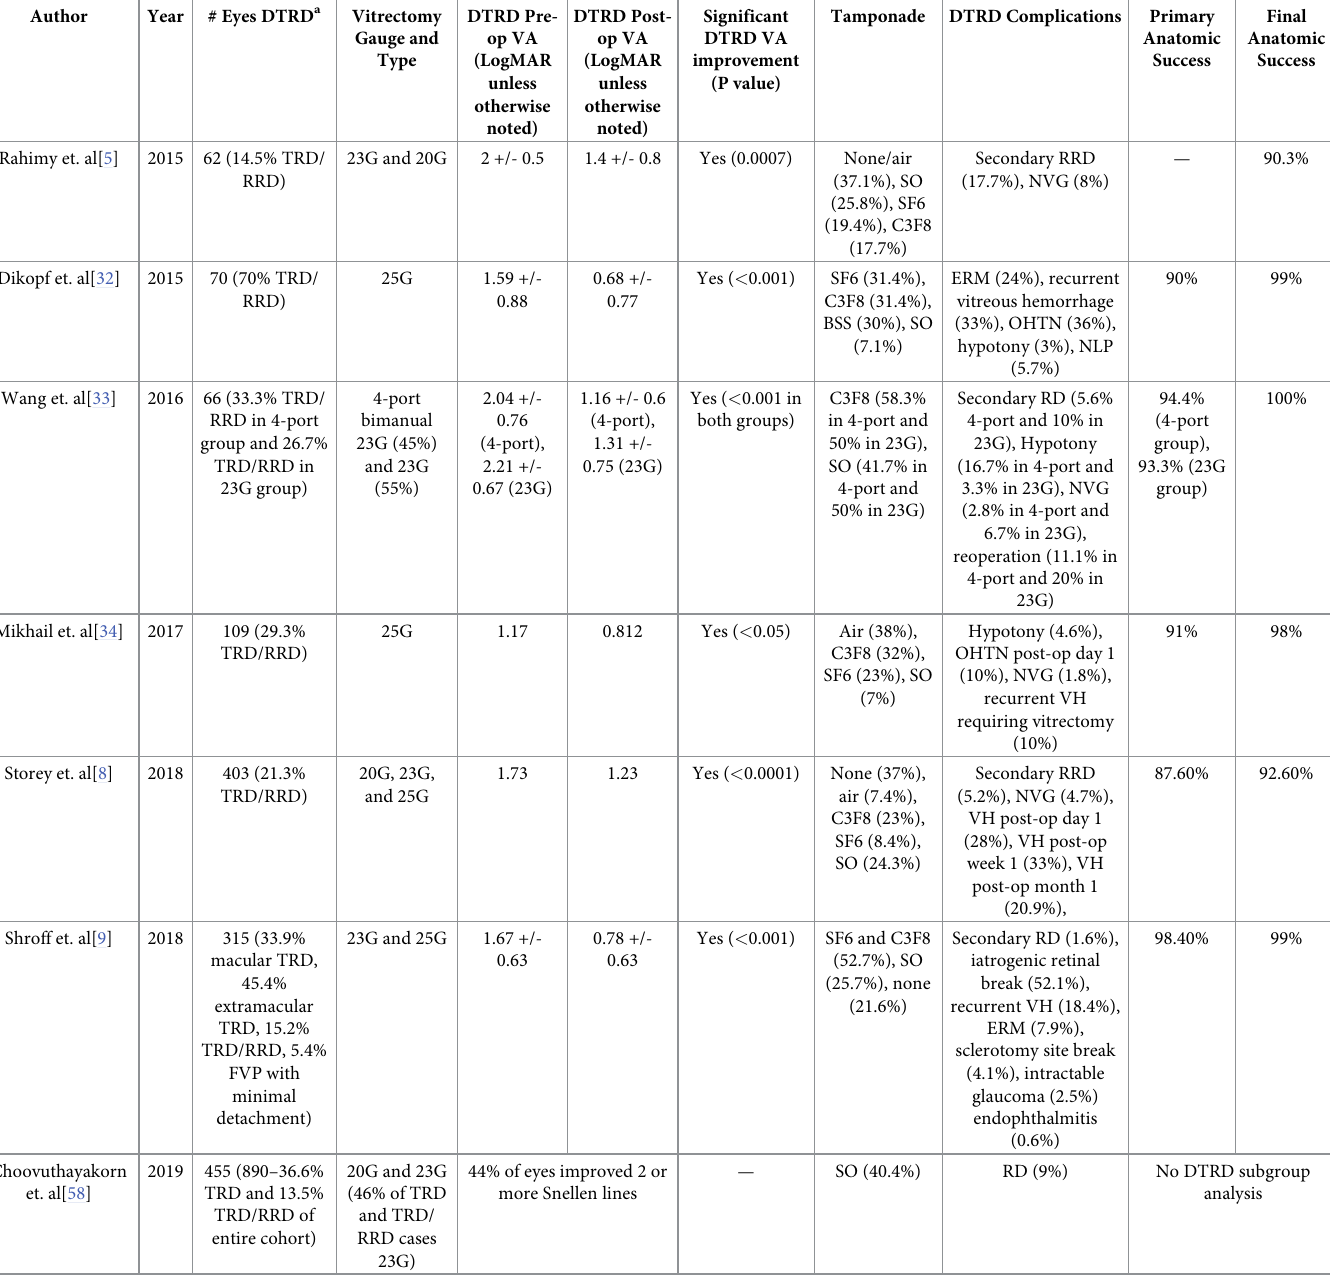
Table 7. Summary of previous literature on small gauge (23G, 25G, and 27G) vitrectomy outcomes (n � 20) in patients with diabetic TRD and TRD/RRD.